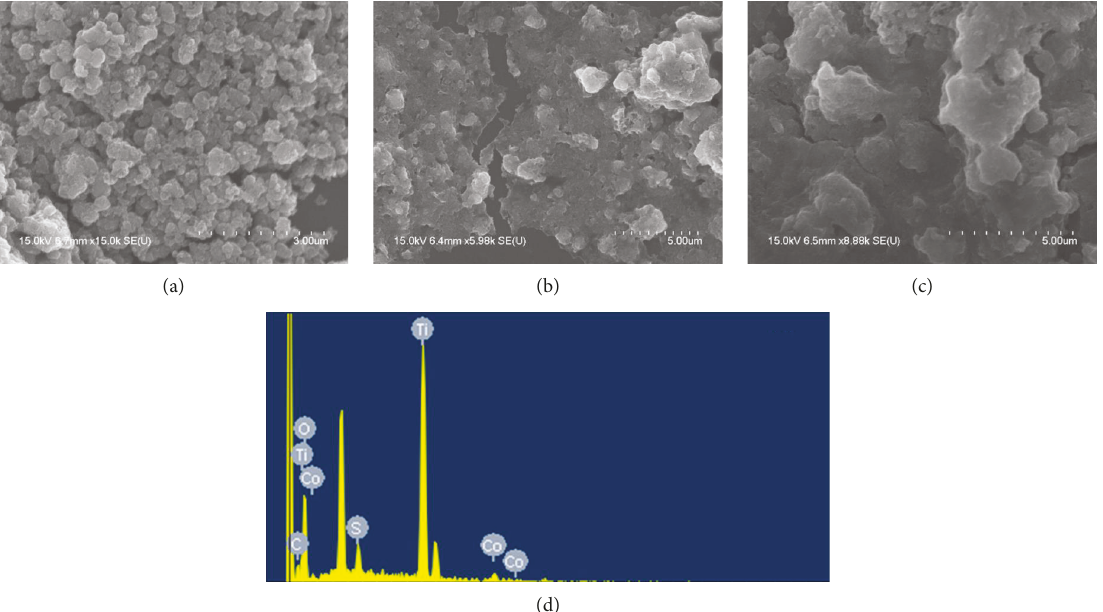
Figure 4: (a) SEM image of 20wt% CoS/TiO spectrum of 20 wt% CoS/TiO